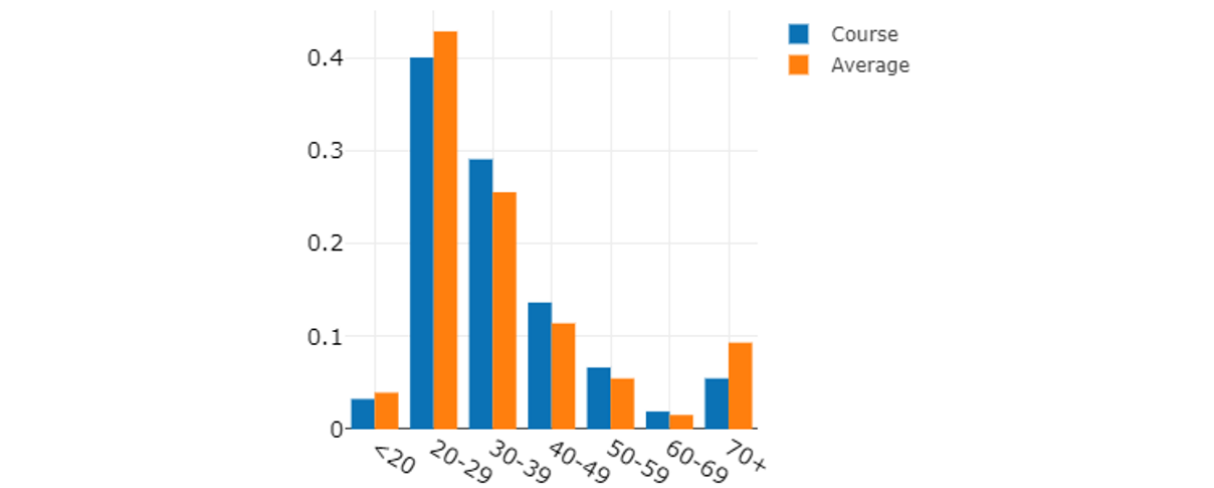
Figure 6. English course use by age